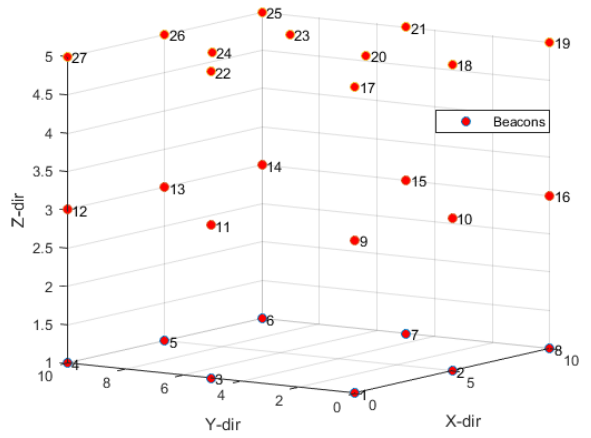
Figure 9. The 27 possible beacon locations for a 10x10x5 theoretical space.